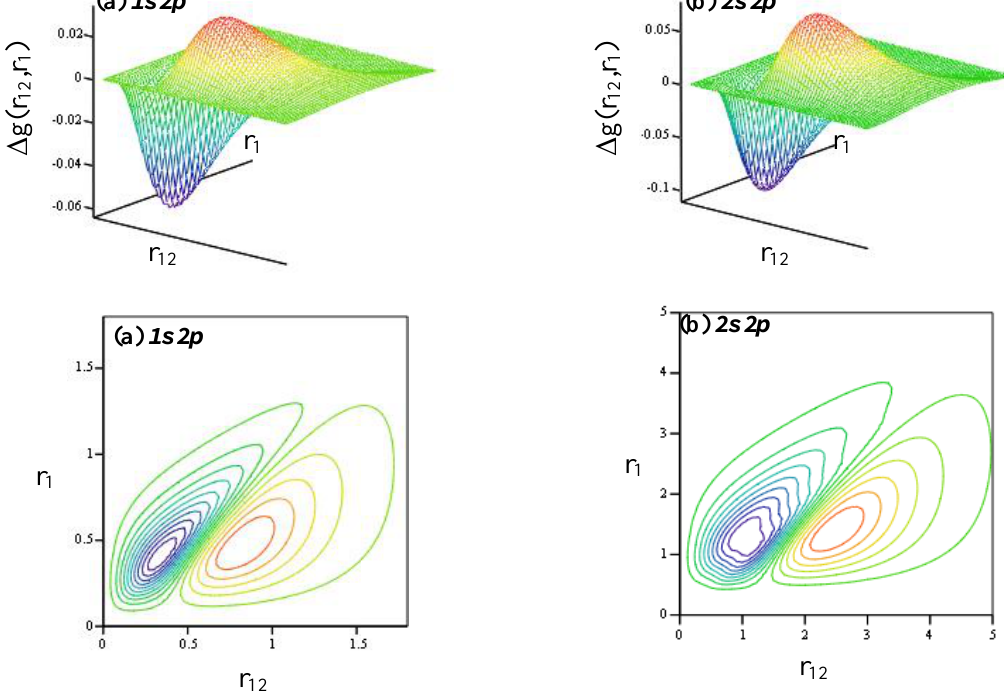
Fig. 11: The surfaces and contours of the partial Fermi hole ∆g(r g (r ,r )-g (r ,r ) for different states of C-atom, (a) 1s 2p and (b) 2s αα 12 1 βα 12 1